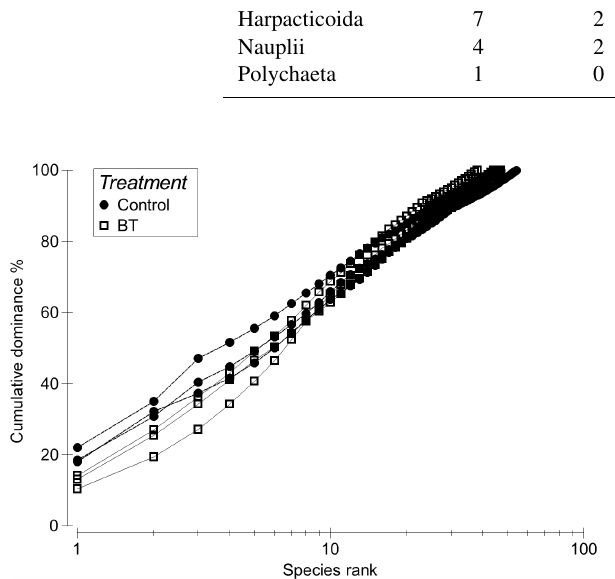
Figure 6. MDS plot of the relative abundances of nematode feeding types in each sample of the Control and Burial treatment (BT) per sediment depth layer with overlying contours of significant (SIM- PROF test) clusters at a 75% similarity level indicated by the letters A–D. NOD is the crushed nodule